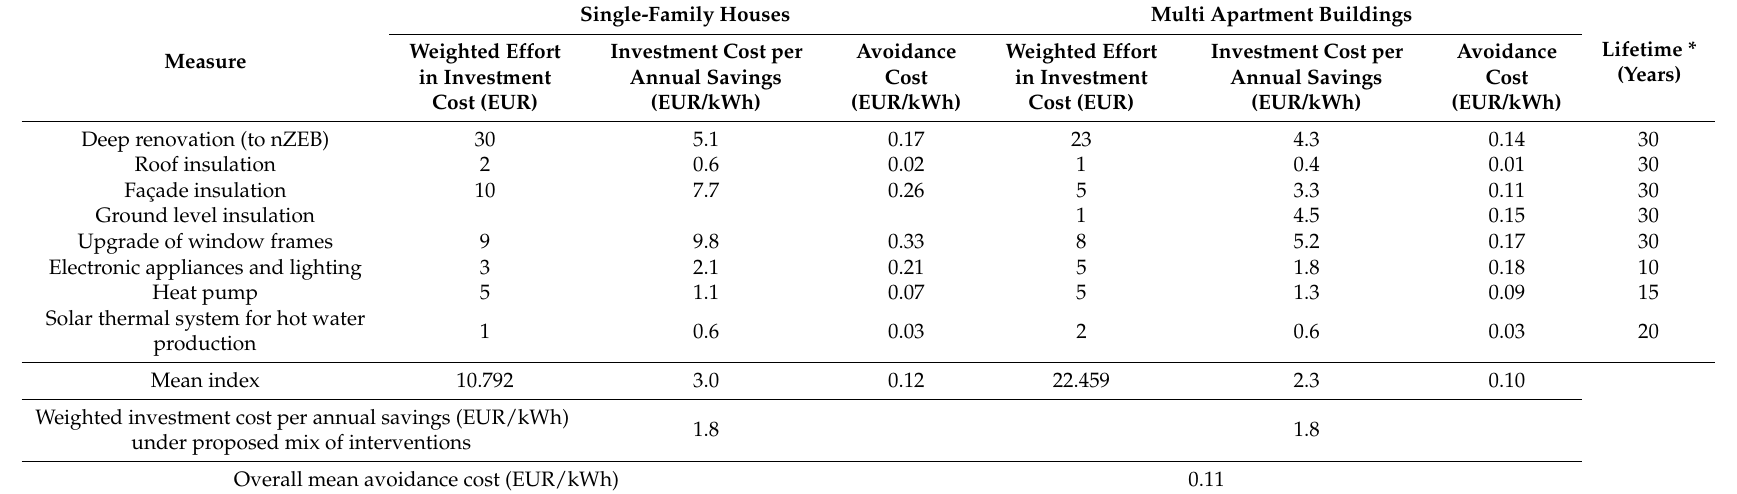
Table 6. Mean values of cost-effectiveness indices of energy efficiency measures in the two main types of residential buildings of Cyprus.